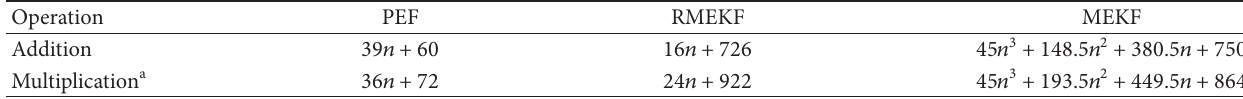
Algorithm 1: TP model transformation algorithm [20]. Table 2: The statistics of the computational cost for three filters.